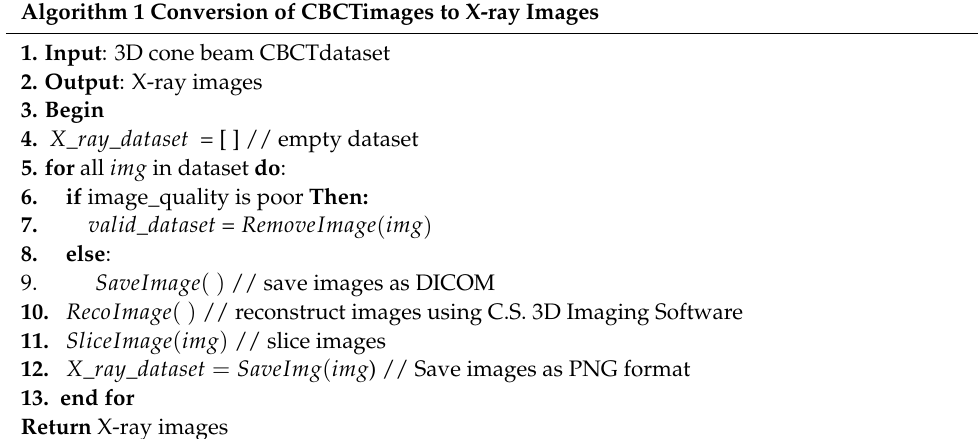
Algorithm 1 Conversion of CBCTimages to X-ray Images